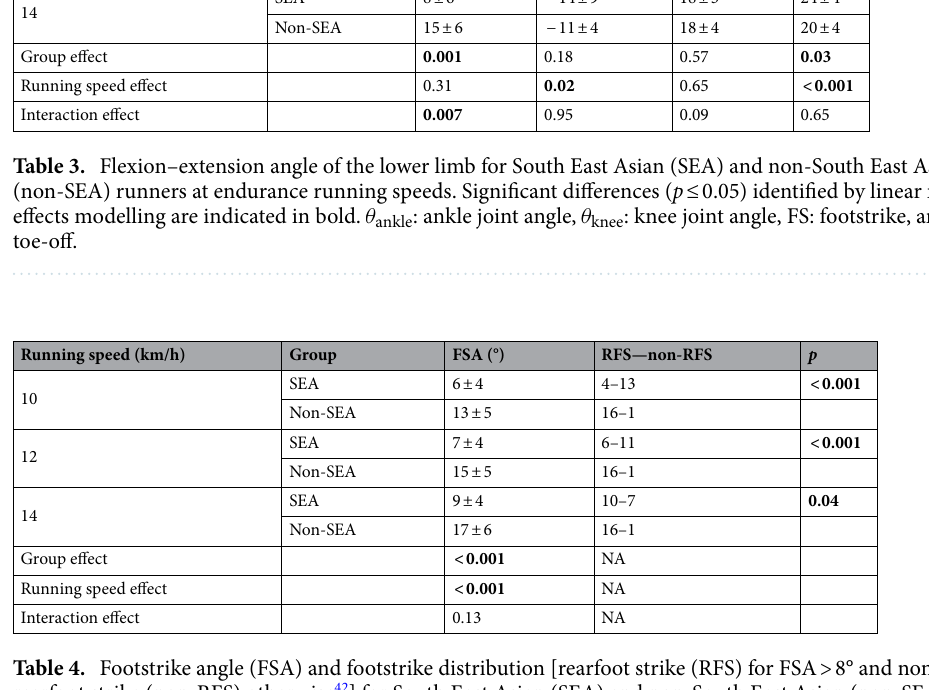
Table 4. Footstrike angle (FSA) and footstrike distribution [rearfoot strike (RFS) for FSA > 8° and non- rearfoot strike (non-RFS) otherwise 42 ] for South East Asian (SEA) and non-South East Asian (non-SEA) runners at endurance running speeds. Significant differences ( p ≤ 0.05) identified by linear mixed effects modelling and by Fisher exact tests are indicated in bold.